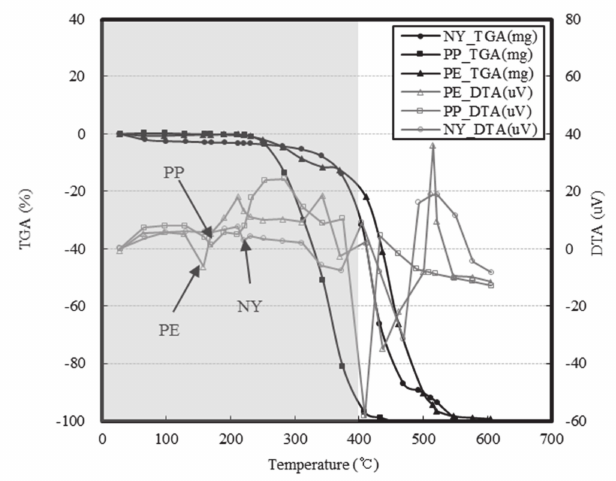
Figure 13. The rmal properties of the fibers employed in this study including the TGA and DTA results.